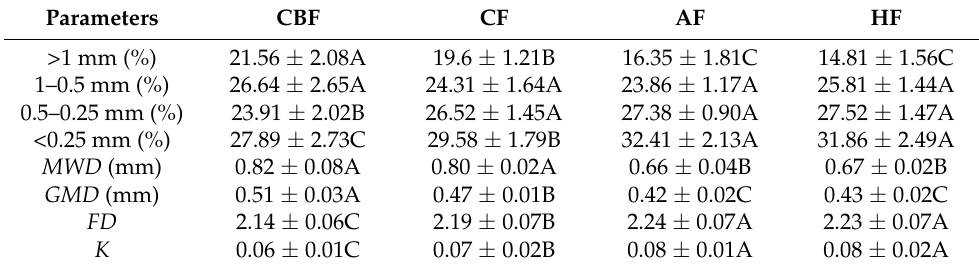
Table 3. Soil aggregate distribution and stability for different forest types.